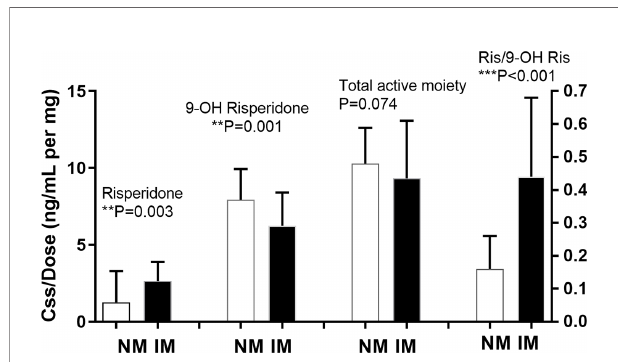
FIGURE 1 | Relationship between CYP2D6 predicted phenotype and risperidone level, 9-hydroxyrisperidone level, total active moiety level, and risperidone/9-hydroxyrisperidone level. Bars represent the median (interquartile range). The metabolic ratio was plotted on the right Y-axis. NM, normal metabolizer; IM, intermediate metabolizer; RIS, risperidone; 9-OH RIS,9-hydroxyrisperidone; RIS/OHRIS, risperidone/9-hydroxyrisperidone ratio. **means p < 0.01, ***means p <